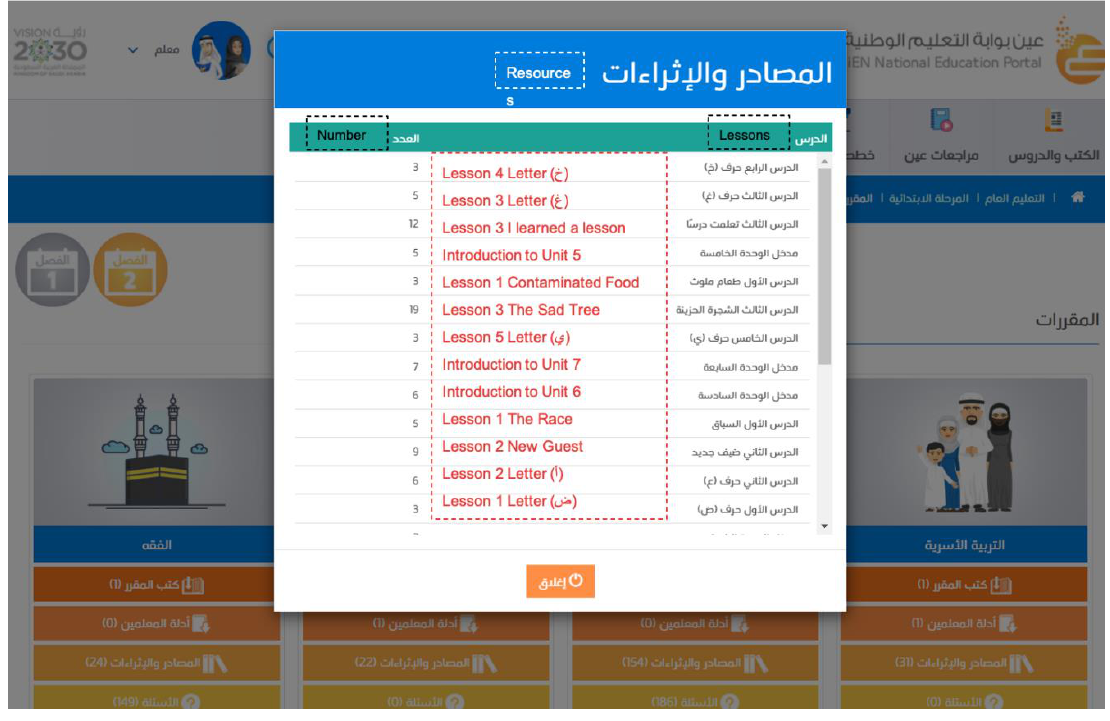
Figure 10. Play interactive content task.